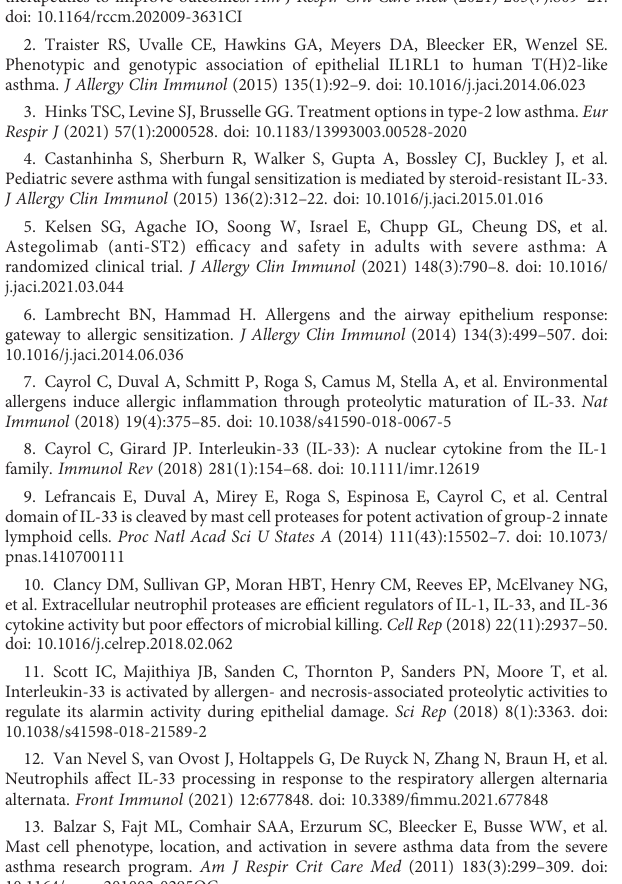
SUPPLEMENTARY FIGURE 1 The levels of IL-4 (A) , G-CSF (B) , and IL-25 (C) in the lung homogenates were measured by Luminex. The data are presented as a scatter plot with a bar ± standard deviation (S.D). Statistical analysis was performed by one-way ANOVA with Dunn ’ s test for multiple comparisons. N=4-6 per group. SUPPLEMENTARY TABLE 1 List of genes differentially expressed in RNA-Seq analysis of in